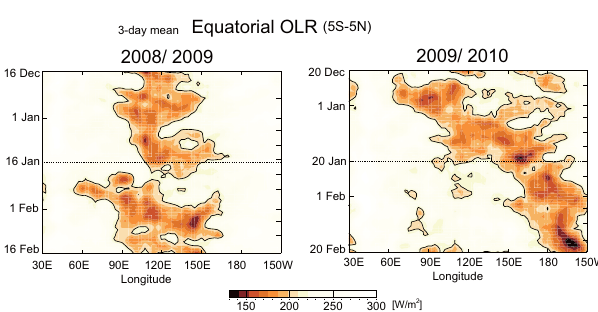
Figure 6. Time–longitude sections of 3-day running mean equa- torial (5 ◦ S–5 ◦ N) OLR over the Indian Ocean–central Pacific sec- tor (30 ◦ E–150 ◦ W) during boreal winter for (left) 2008/2009 and (right) 2009/2010. The figure displays a 2-month period centred on the onset day of the tropical stratospheric upwelling events (16 Jan- uary 2009 and 20 January 2010) indicated by horizontal solid